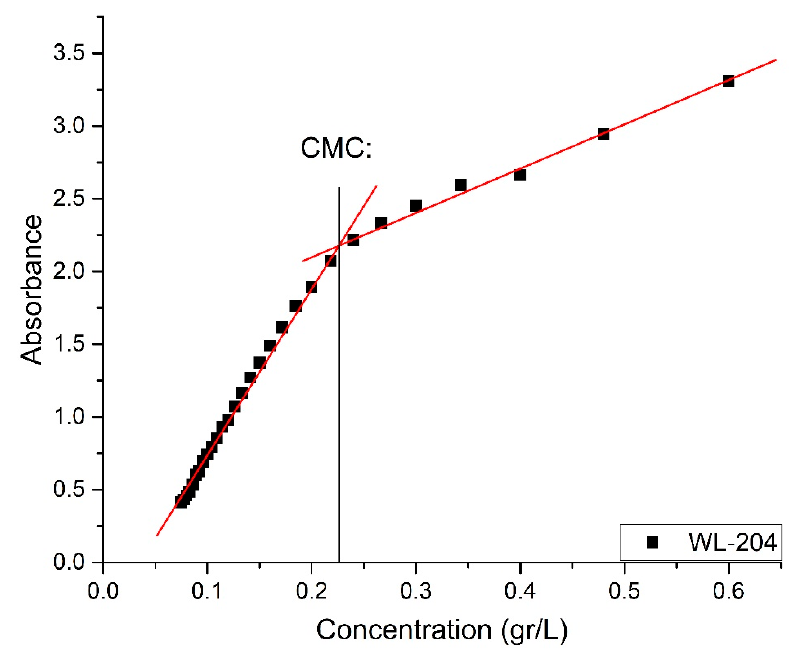
Figure 7. Absorbance versus concentration plots of bioconjugate of oleic acid and L-cysteine (MAT). Wavelength 204 nm.